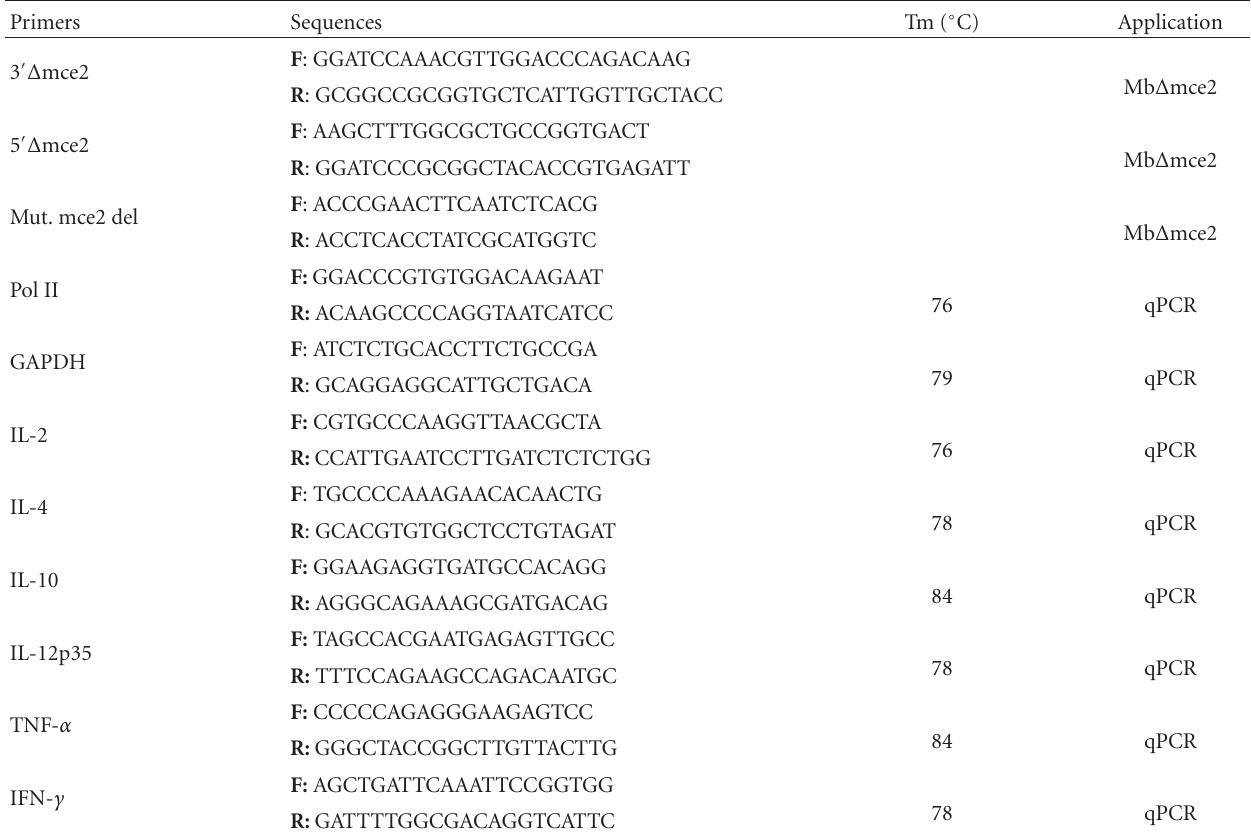
Table 1: Primers used in this